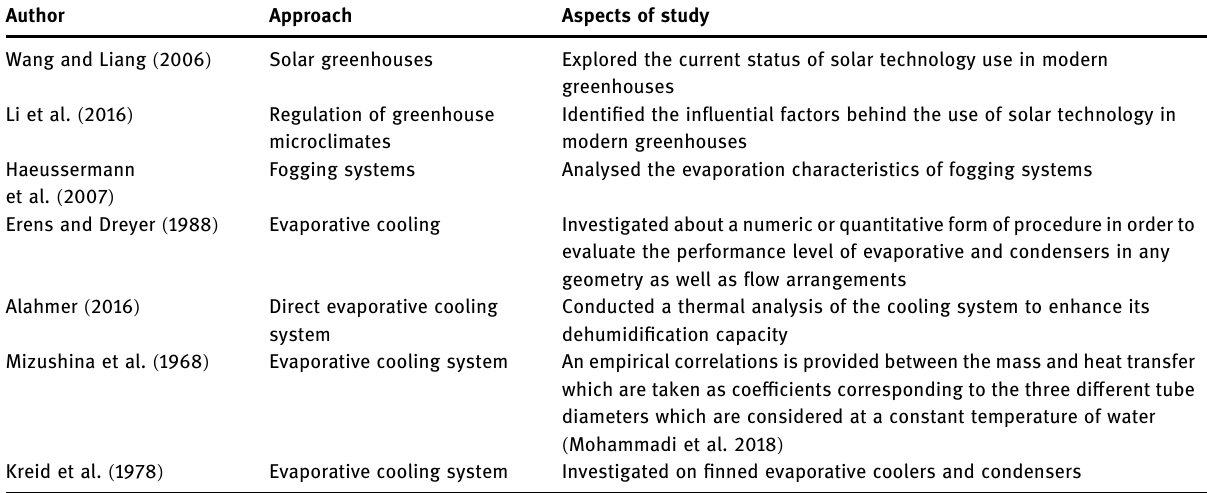
Table 2: Reviewed articles, approaches, and parameters studied